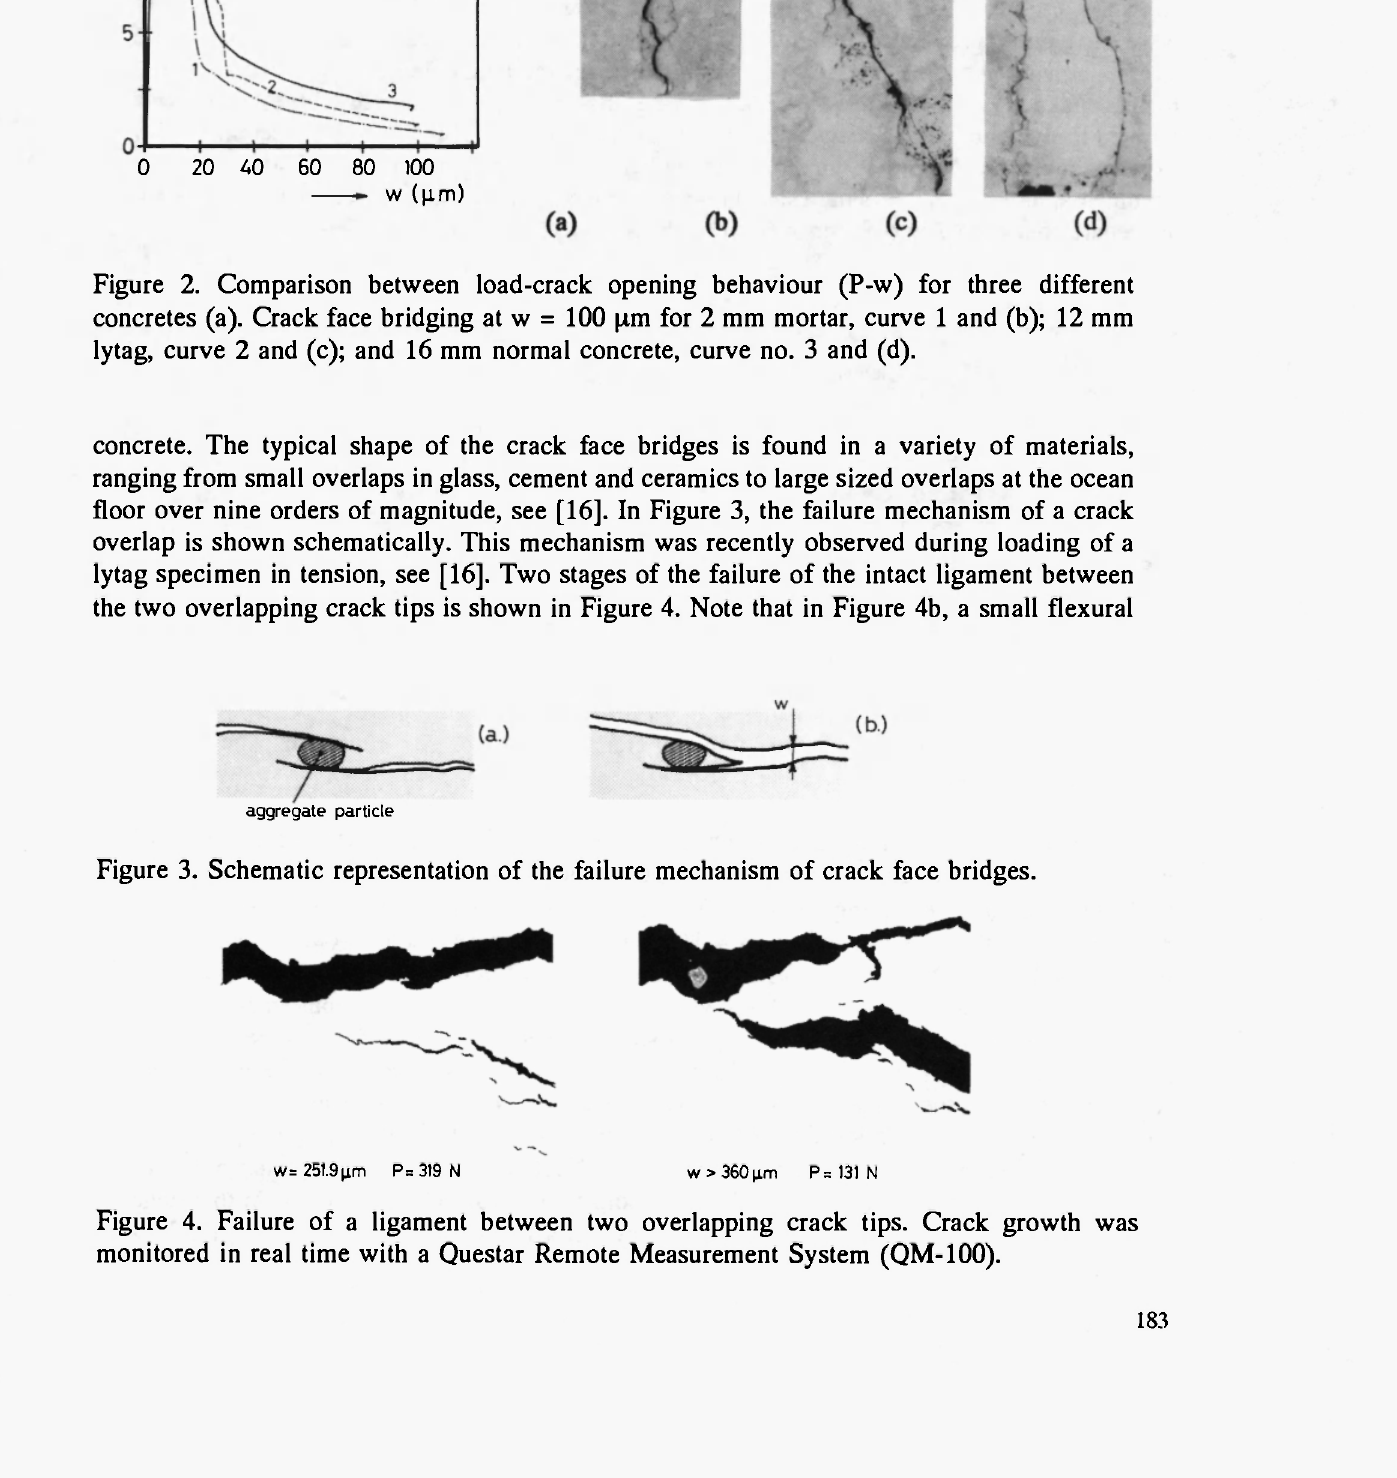
Figure 4. Failure of a ligament between two overlapping crack tips. Crack growth was monitored in real time with a Questar Remote Measurement System